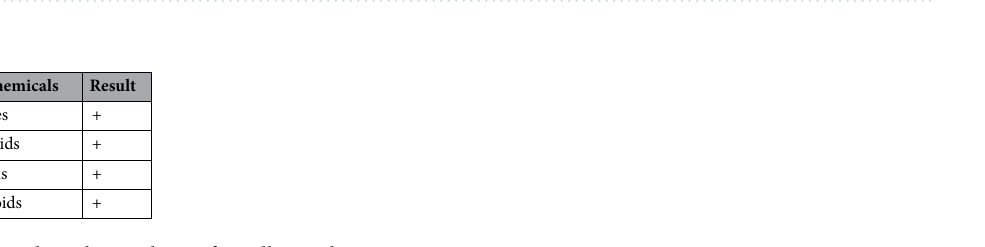
Table 1. Phytochemical test of Oscillatoria limnetica